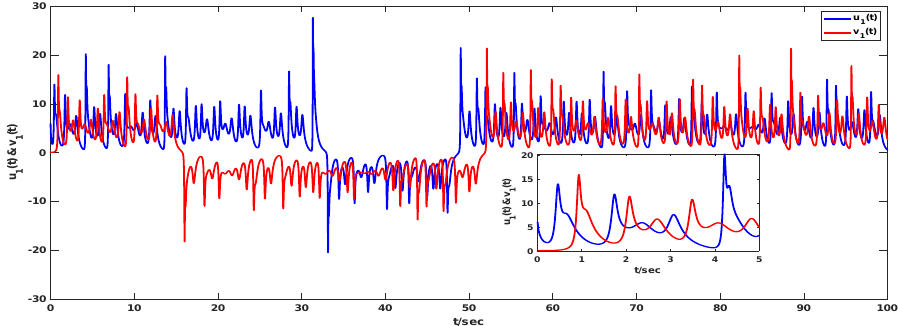
Figure 9. Time response of the states ( t , u 1 ( t )) and ( t , v 1 ( t )) of the drive-response systems (13) and (14) with fractional order q =